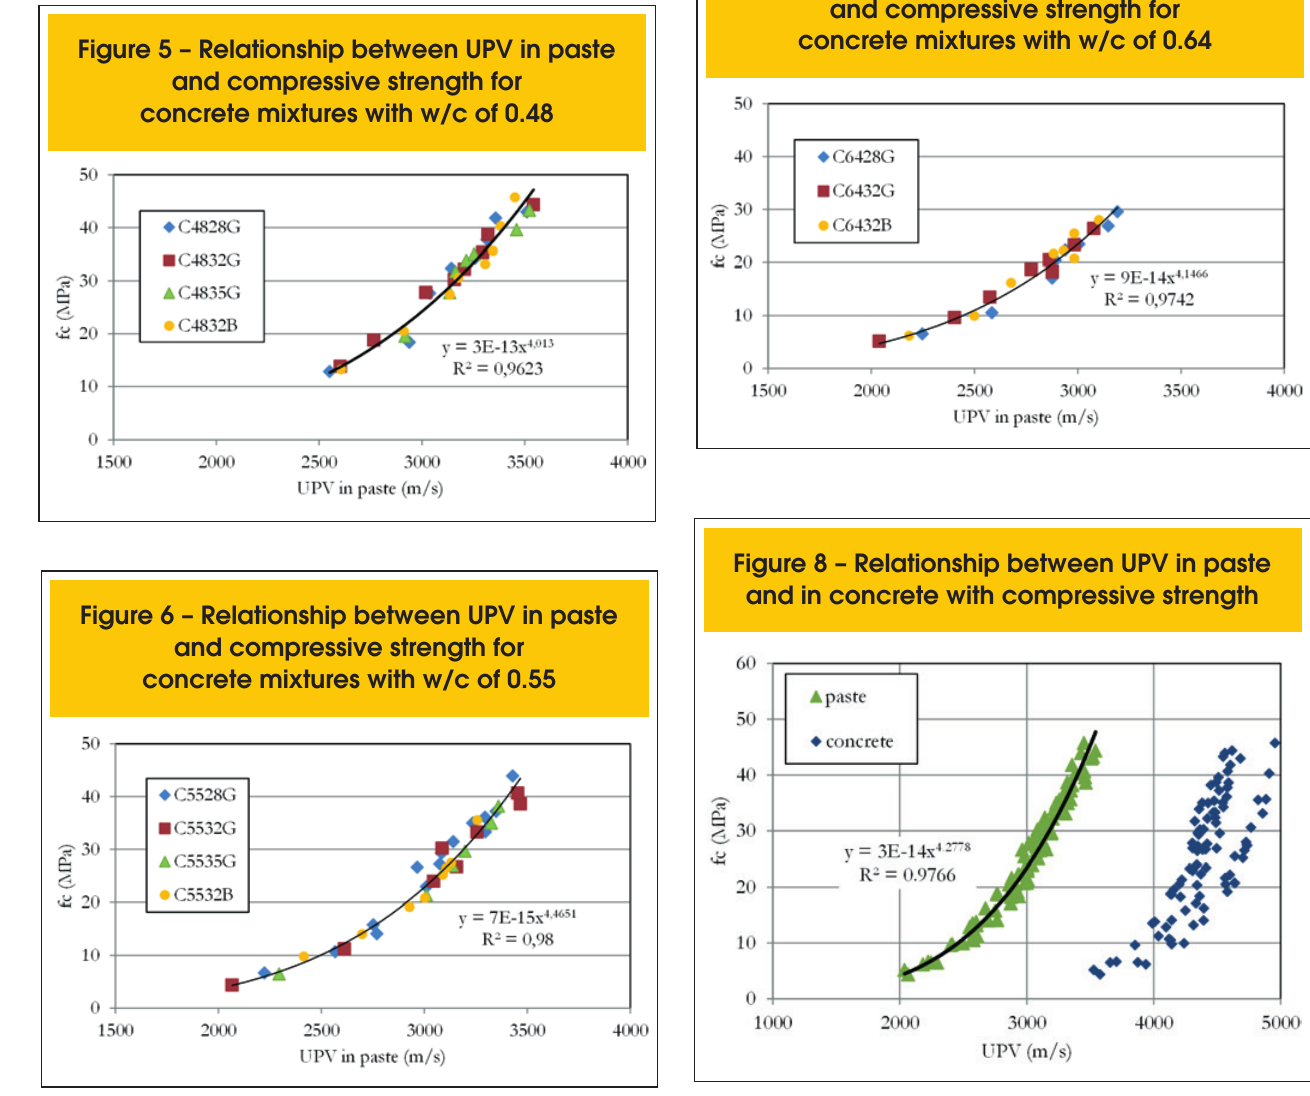
Figure 7 – Relationship between UPV in paste and compressive strength for concrete mixtures with w/c of 0.64